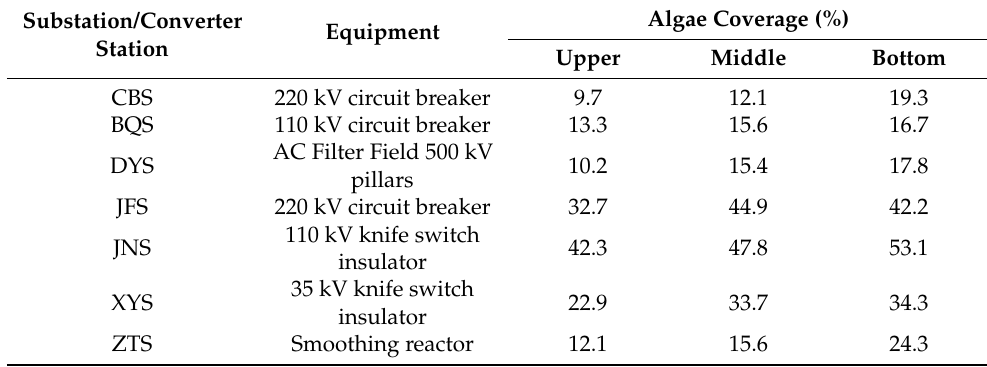
Table 3. The degree of algal growth on different parts of the insulator.